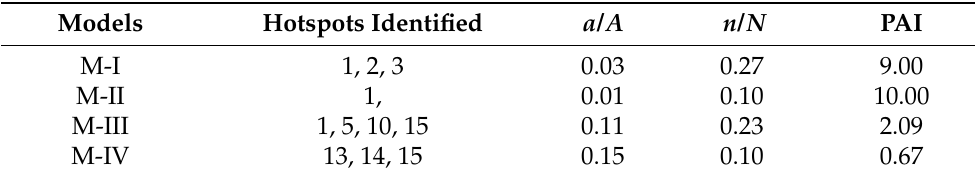
Table 2. Hotspots identified, their combined relative area ( n / N ) and hit rate ( a / A ) for the four models in the hypothetical